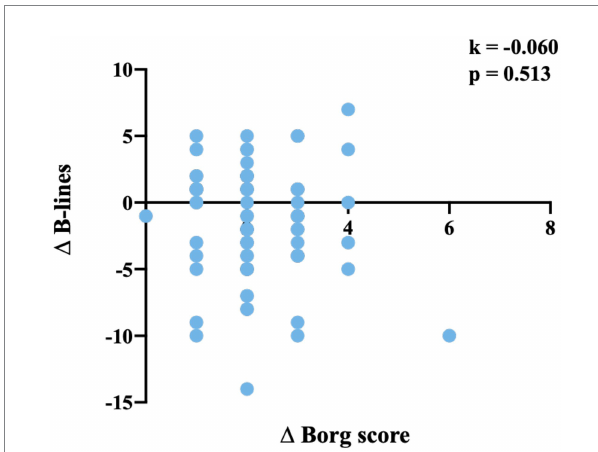
FIGURE 2 Correlation analysis of ∆ B-lines and ∆ Borg score. The scatterplot shows no correlation between the increase in the Borg score ( ∆ Borg score) and the change in the number of B-lines ( ∆ B-lines; k = − 0.060, p =